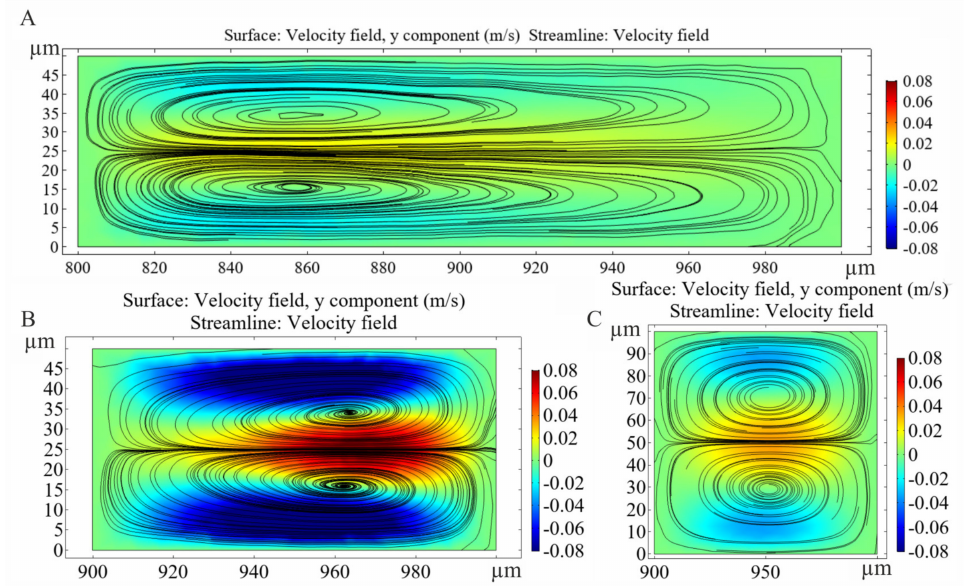
Figure 6. Evolution of Dean vortices in the H50_W cr 150 ( A ), H50_W cr 50 ( B ) and H100_W cr 50 ( C ) microfluidic channels after the restrictions at 3 µ L/s lateral flow rate. The y components of velocity field calculated by